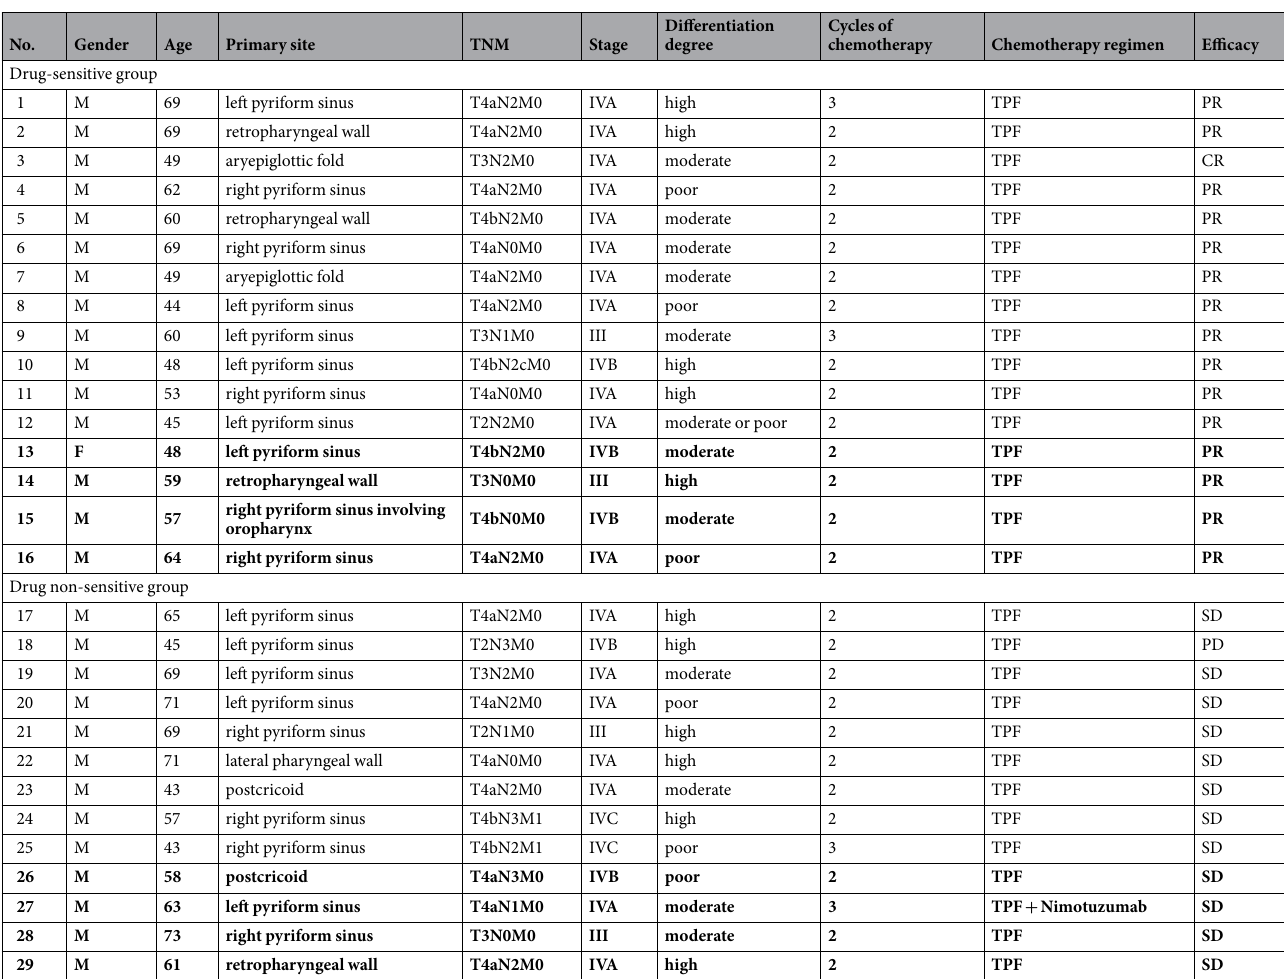
Table 1. Clinical characteristics of the first group of patients. CR, complete response: Disappearance; confirmed at four weeks; PR, partial response: 50% decrease; confirmed at four weeks; SD, stable disease: Neither PR nor PD criteria met; PD, progressive disease: 25% increase; no CR, PR, or SD documented before increased disease. 13–16 are the second batch of the drug-sensitive group (bold). 26–29 are the second batch of the drug non- sensitive group